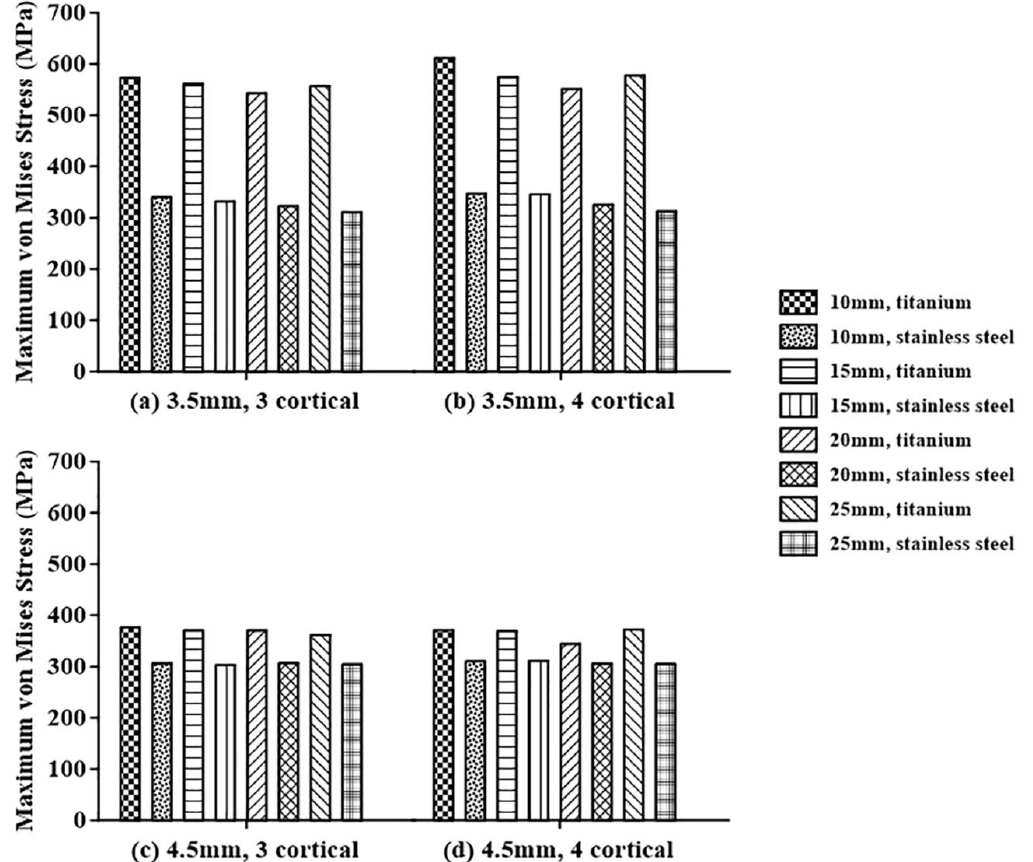
Figure 6. Analysis of the maximum von Mises stresses of the syndesmotic screw in terms of the syndesmotic screw material for screws with diameters of: ( a ) 3.5 mm penetrating three cortical bones, ( b ) 3.5 mm penetrating four cortical bones, ( c ) 4.5 mm penetrating three cortical bones, and ( d ) 4.5 mm penetrating four cortical bones.